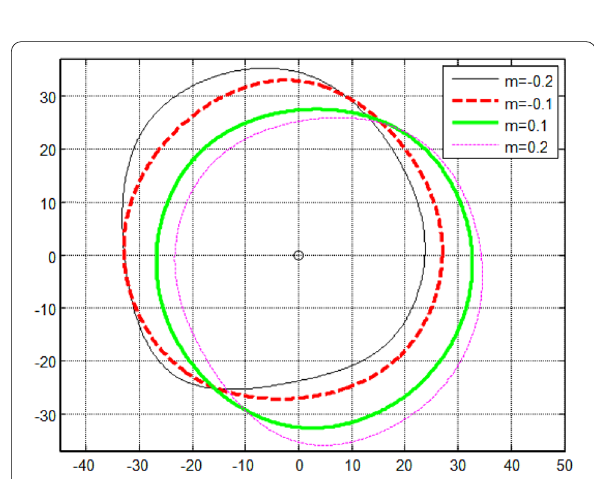
Figure 14 Tension pulley pitch curve corresponding to different m values